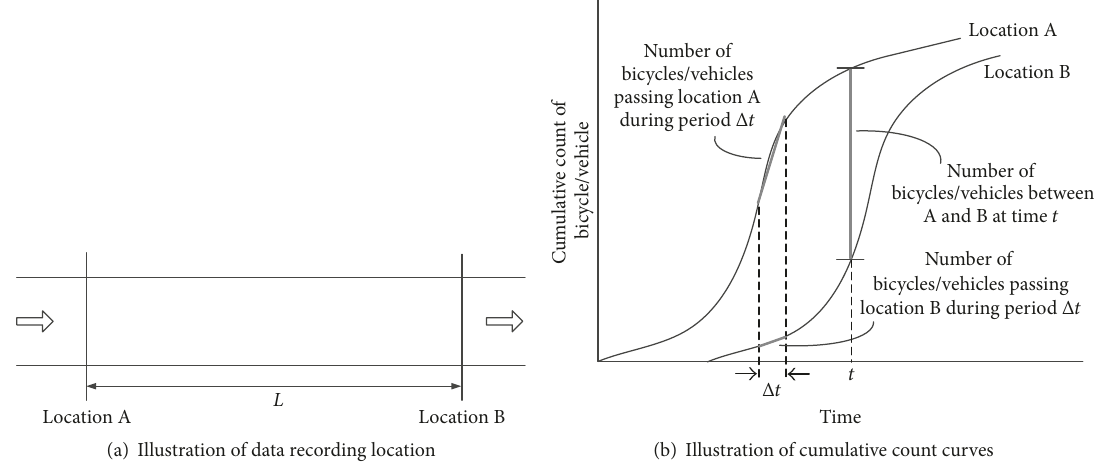
Figure 3: Traffic flow information extracted from cumulative